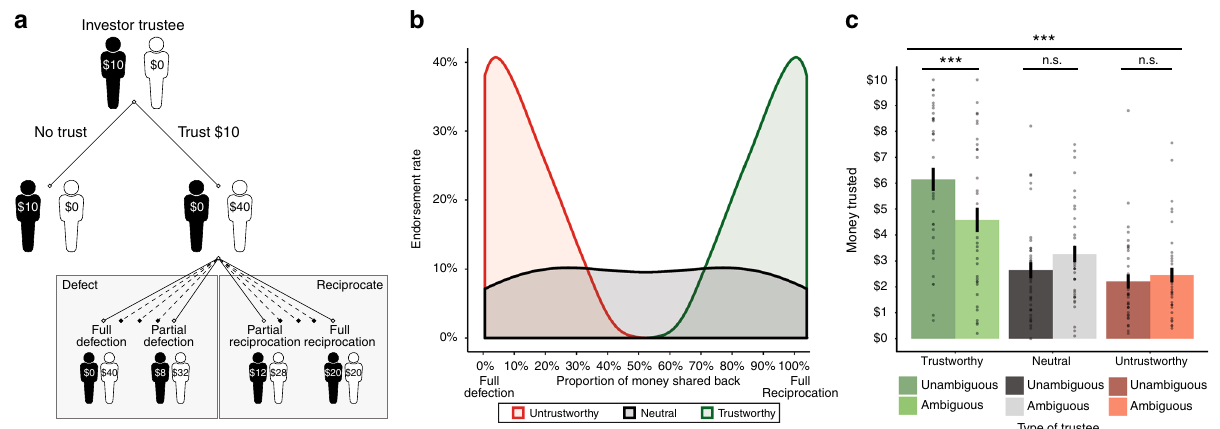
Fig. 2 Experiment 2 task structure and results. a In the trust game, subjects (investors) were endowed with $10 and decided whether to share their money with the trustee, knowing that the money entrusted was quadrupled once sent to the trustee. If subjects entrusted their money, the trustee could reciprocate any proportion of money from returning nothing ($0) to the maximum amount (i.e., double the invested money). The decision tree depicts an example of a decision to trust and the various possibilities the trustee could choose from, from full defection to full reciprocation. b Each trustee was yoked to a different reciprocation algorithm: trustworthy trustees typically reciprocated, the neutral trustees were equally likely to defect or reciprocate (e.g., a uniform density across all possibilities); untrustworthy trustees typically defected. The proportion of money shared back refers to the maximum reciprocation (i.e., double the invested money. c A repeated measures ANOVA reveals subjects were sensitive to the trustworthiness of the trustee, entrusting the most money to trustworthy trustees and the least money to untrustworthy trustees. This effect was modulated by ambiguity levels associated with the trustees (whether feedback was presented), such that greater ambiguity had a negative effect for the trustworthy trustees, and no effect for neutral and untrustworthy trustees. Asterisks indicate signi fi cant differences (*** p < .001). Error bars represent ± 1 standard error of the